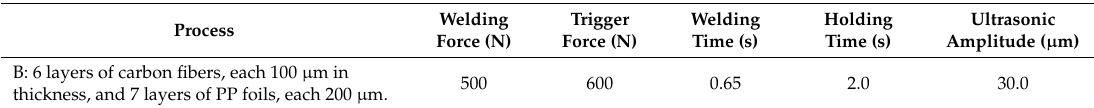
Table 2. Overview of the process conditions and the parameters for the ultrasonic fabrication of CFRP with the Herrmann Ultraschall HiQ DIALOG 1200 ultrasonic welding machine.